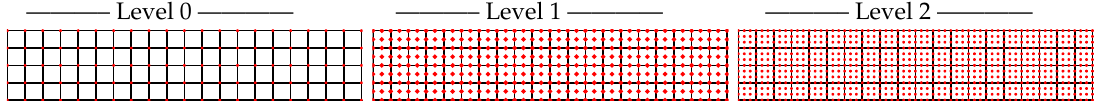
Figure 3. p-refined hierarchy of meshes used for model problem 1.